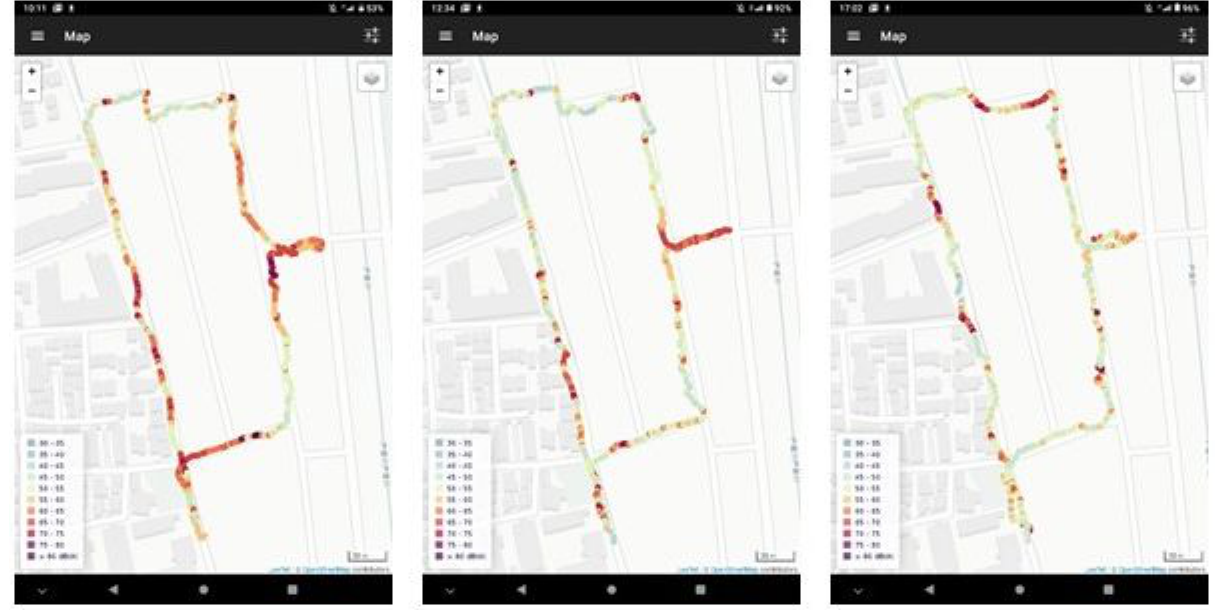
Figure 4: Noise maps taken from the results of soundwalks on 20 July 2020 using Noise Capture. This route includes Points (1) to (6) and the surrounding area. (a) 09:40–45; (b) 12:10–15; (c) 16:40–45. Red marks indicate noise levels higher than 60 dBA (LA